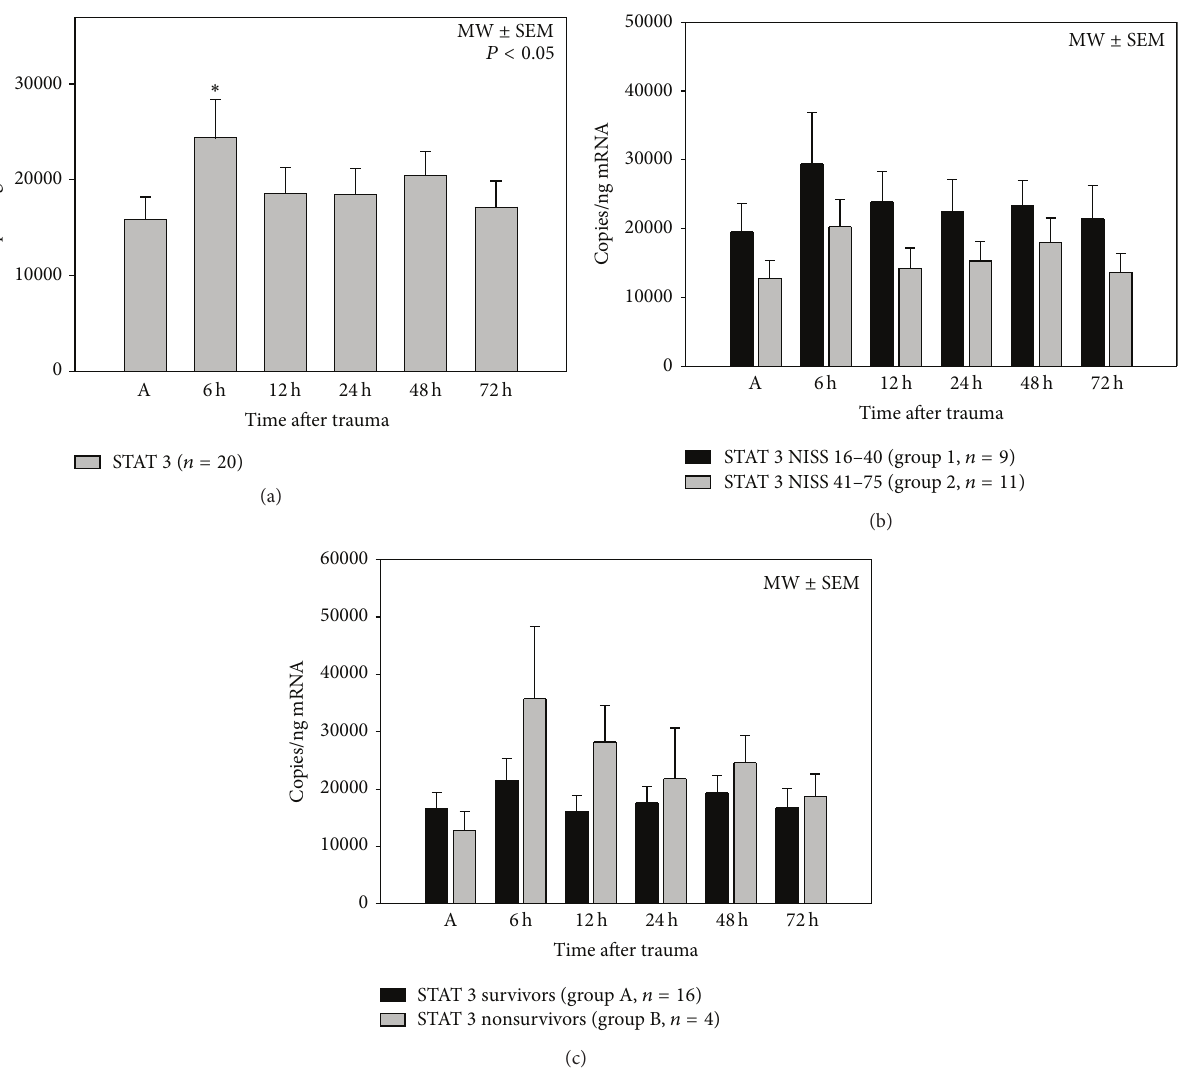
Figure 2: Posttraumatic STAT 3 mRNA expression profiles after major trauma in all patients (a), depending on injury severity (NISS, (b)) and depending on outcome (survival > 90 days, (c)), ∗ 𝑃 < 0.05 SNK-test. STAT 3 mRNA expressions showed increasing expression levels posttraumatically with a significant maximum level 6 h after the traumatic event in all patients ( 𝑛 = 20 ). STAT 3 mRNA expressions were lower in patients with a NISS between 41 and 75 points compared to patients with a NISS less than 41 points. Nonsurvivors showed a higher STAT 3 expression level within the whole posttraumatic period without significant